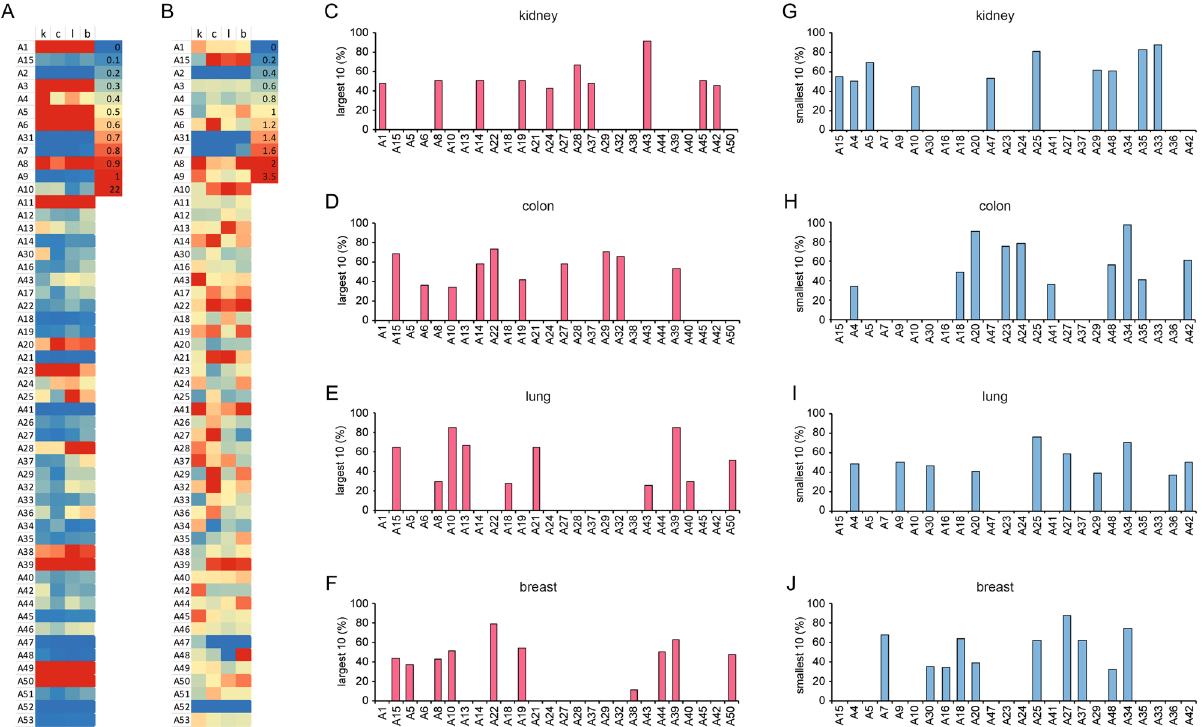
Figure 2. Expression of SLC25 genes in tumor and uninvolved tissue. ( A ) Heat map of uninvolved tissue FPKM ratios of single SLC25 over the sum of MitoCarta genes (FPKM SLC25Ax/ΣFPKM MitoCarta) from same person. ‘k’ (KIRC), ‘c’ (COAD), ‘l’ (LUAD), and ‘b’ (BRCA) with values shown × 10 3 . ( B ) SLC25Ax/ΣFPKM MitoCarta ratios for tumor over those of uninvolved tissue (same individual). The L10 transporters [( C ) KIRC], [( D ) COAD], [( E ) LUAD], [( F ) BRCA] and the S10 transporters [( G ) KIRC], [( H ) COAD], [( I ) LUAD], [( J ) BRCA]. The percentage of patients with the indicated L10 and S10 of the total number of patients probed is shown in ( C – J ). The transporters are arranged numerically as indicated in Table 1. Those transporters with sequence similarity are grouped together between the red